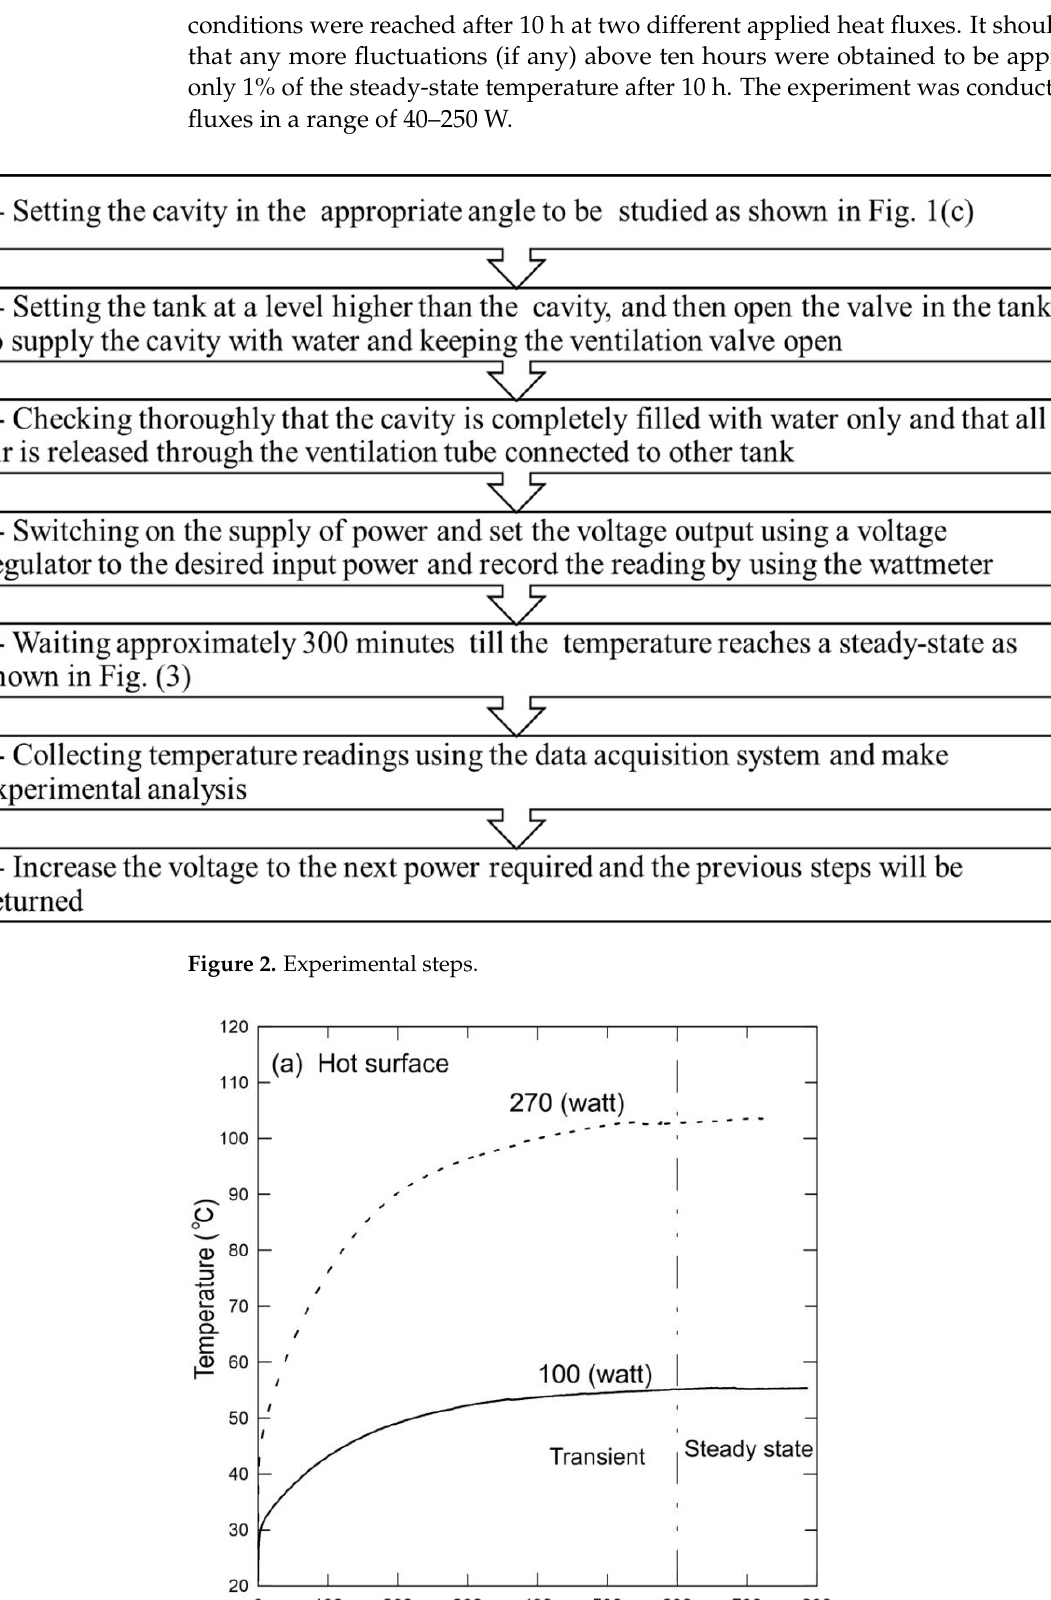
Figure 3. Steady-state condition reached after almost 600 min: ( a ) hot stainless-steel surface; ( b ) cold stainless-steel surface. 4. Experimental Analyses Heat transfers from the constant heat flux flexible heater were via conduction through the lower stainless-steel plate, by natural convection through the water in the cavity, conduction through the upper stainless-steel plate, and forced convection through the ambient air. In addition, the heat, which may be lost through the enclosure sides and from the heater to the lower Bakelite surface (8), was estimated and obtained, at most, to be 7.9% and 3.1%, respectively. Figure 4 shows a schematic of the experimental setup with boundary conditions that specified that the lower stainless-steel surface was subject to constant heat flux, the sidewalls were insulated, and the upper stainless-steel surface was subject to ambient air at 3.0 m/s. The net radiation heat transfer exchange between the hot